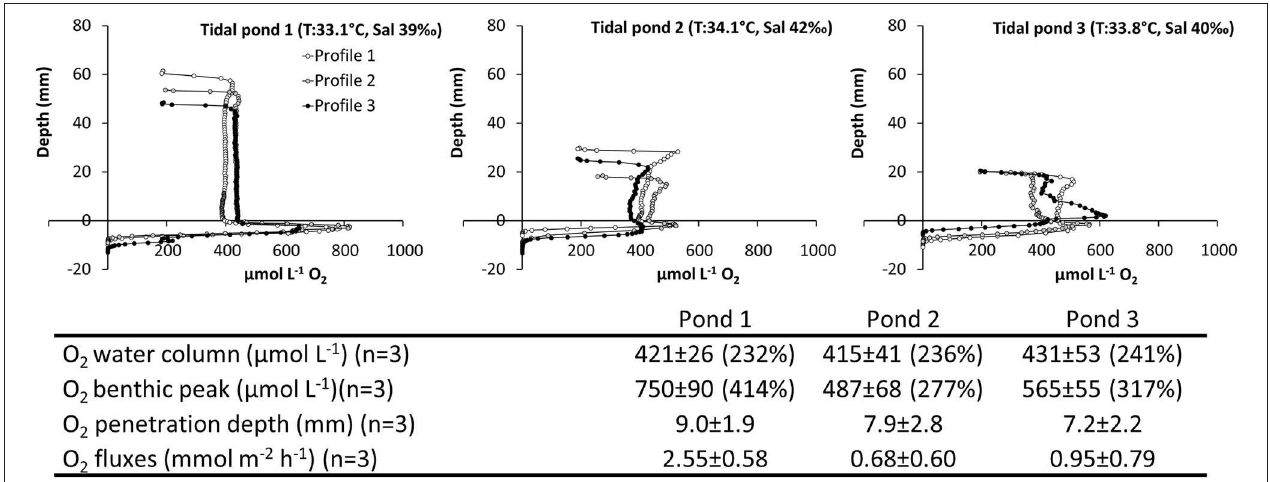
FIGURE 8 | Spatiotemporal variation of O 2 in three independent, but closely located salt marsh ponds. Vertical profiles of O 2 measured from the air-water interface through the water-column and into the sediment. Profiles were measured consecutively within a 2.5h period; (Top panel) pond 1 (Time: 11:10–12:30), pond 2 (Time: 12:45–13:45), and pond 3 (14:00–14:45). (Table inlet) Table of the average O 2 and pH conditions. Percent (%) refers to the % O 2 atmospheric saturation.